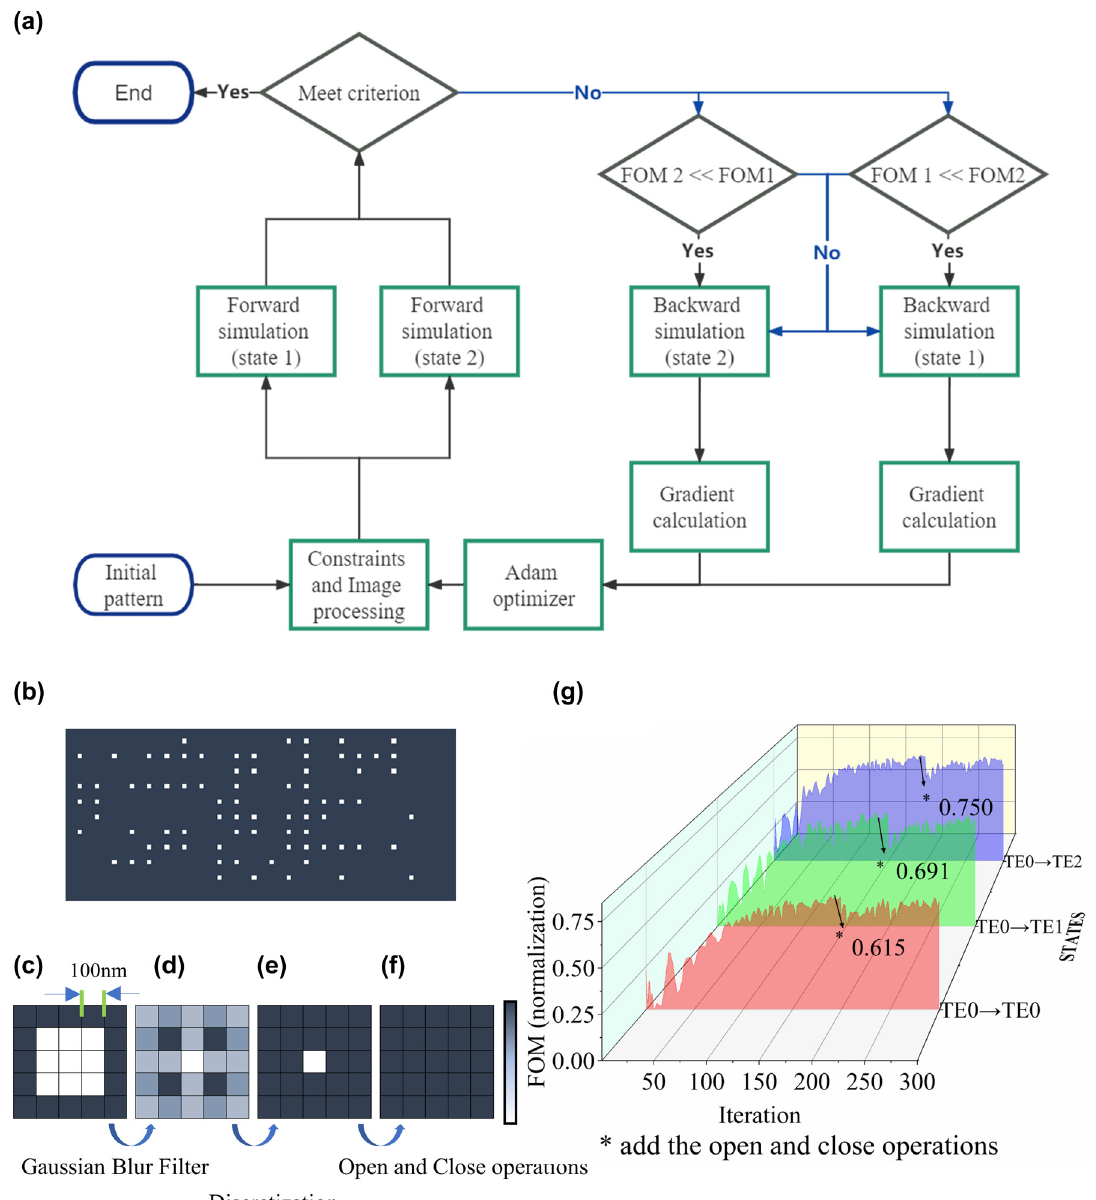
Figure 2: The flow chart of the inverse design method. (a) The flow chart of the inverse design method. (b) The initial pattern of topology optimization. The dark blue blocks represent cells made of silicon nitride. (c) Partially enlarged view of the design region. (d) Structure after Gaussian blur filter. (e) Structure after discretization. (f) Structure after open and close operations. (g) Evolutions of FOM over the topology optimization process.